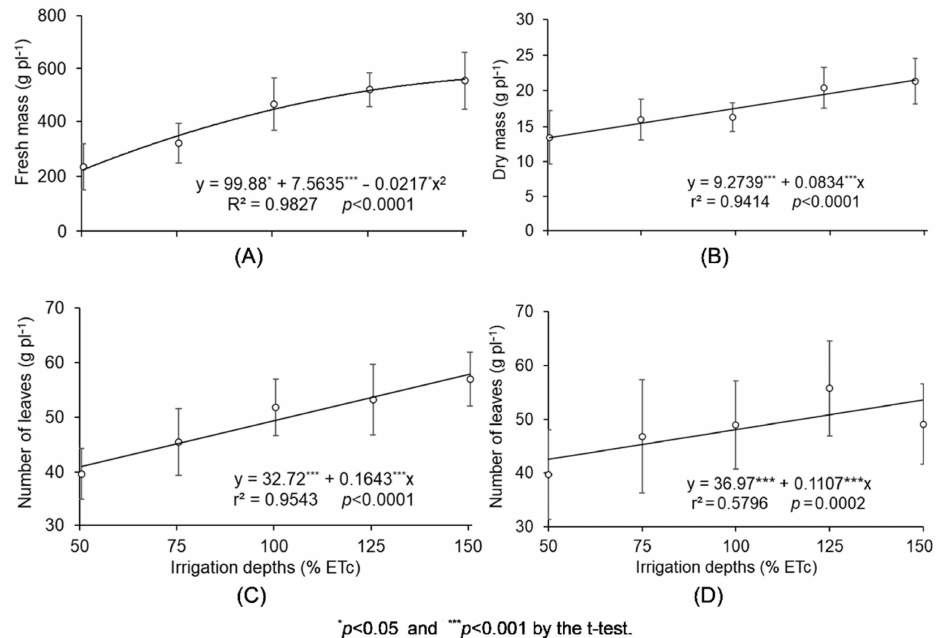
Figure 6. Shoot fresh mass ( A ) and shoot dry mass ( B ) of lettuce grown in cycle 1 and number of leaves in the first ( C ) and second ( D ) cultivation cycles as a function of different irrigation